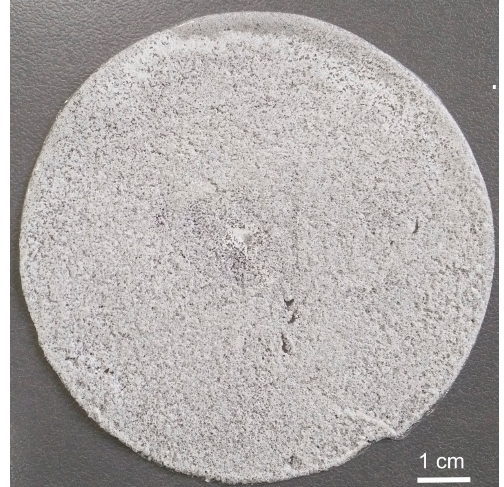
Figure 5. The porous dressing material from co-polyester BAC 90/10 and NaCl as the porophor agent in the form of porous membrane with the bactericide substance (micro silver particle).